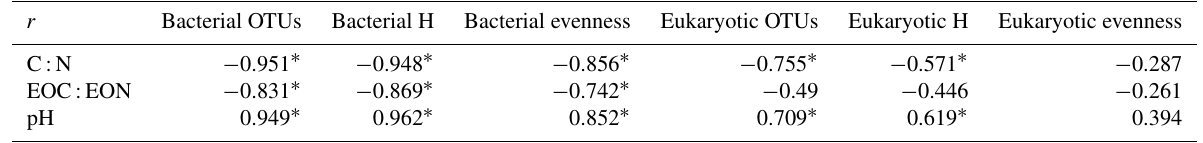
Table 4. Correlation between key physiochemical factors and operational taxonomical units (OTUs) numbers, Shannon diversity index (H) and evenness of soil bacteria and eukaryotes in 78-year-old forest plantations with different tree species.